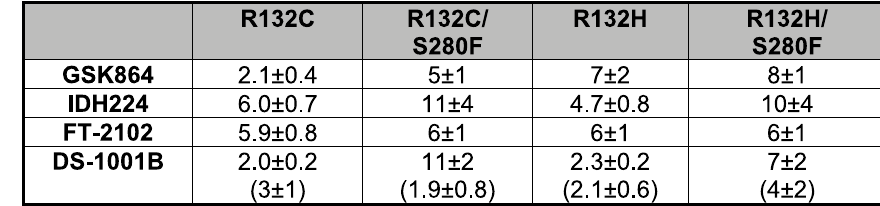
molecules. Conditions: 20 µ M IDH1 variant, 20 µ M inhibitor, cone-voltage: 100V. c K D determinations(standarderrorsofthemean)measuredbybynon-denaturing MS (20 µ M enzyme, technical errors: n =3 for the z =19, 20, 21 charge states) and CPMG NMR (values in brackets, 10 µ M enzyme, n =2). Non-denaturing